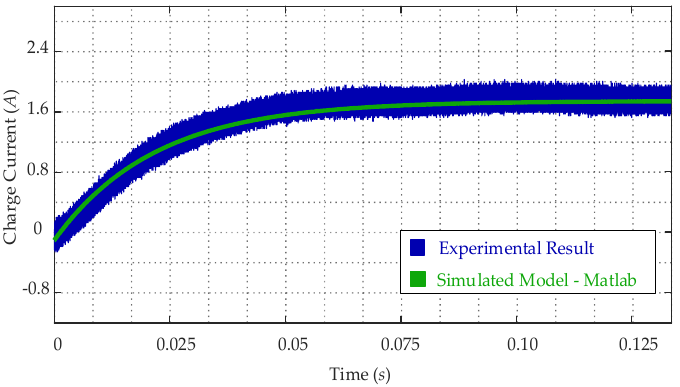
Figure 8. Validation of the converter model on the charging mode (step-down mode).